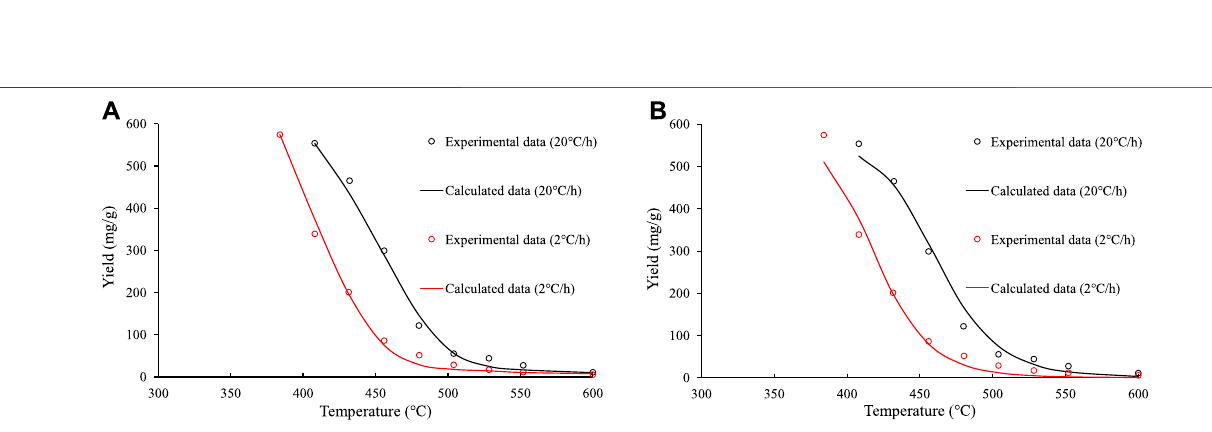
FIGURE 9 | Comparison of the fi tting effects of the parallel fi rst – order reaction model and the overall nth – order reaction model on experimental data of the liquid hydrocarbon in the closed system experiments on sample No. 9. (A) parallel fi rst – order reaction model. (B) overall nth – order reaction model.